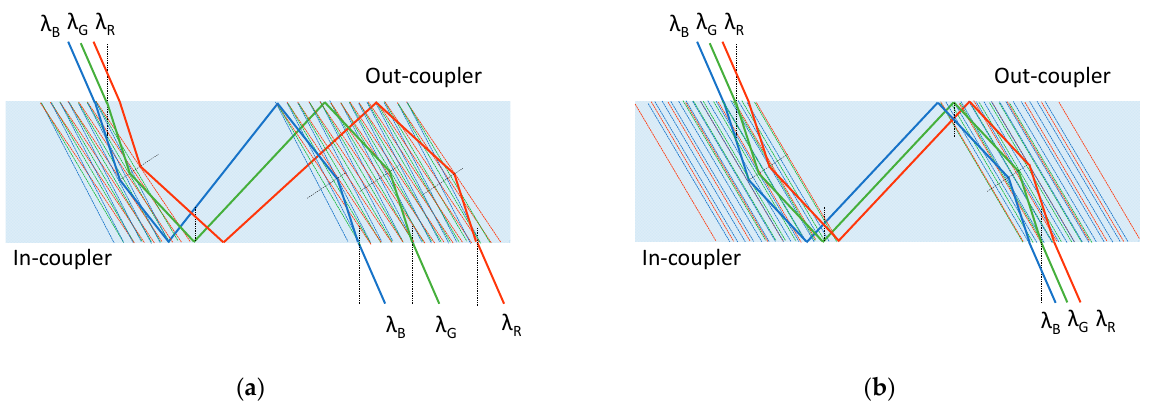
Figure 8. Formation of a color point: ( a ) by MVHGs based on one surface periodicity in the waveguide, ( b ) by MVHGs based on three surface periodicities.